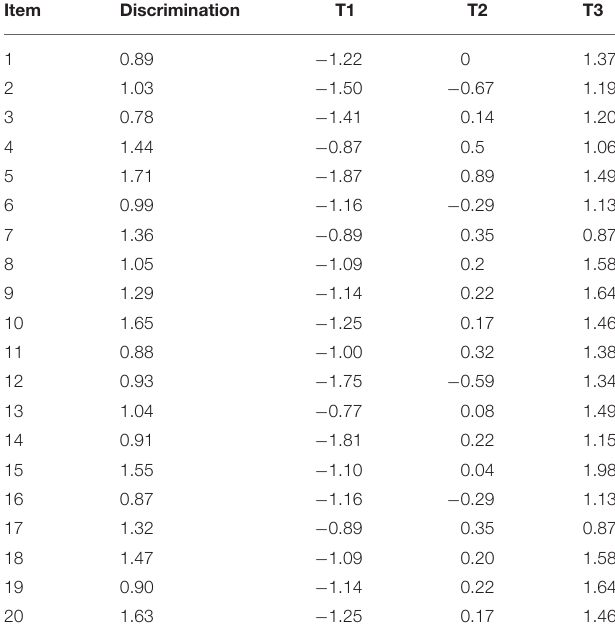
TABLE 1 | Data generating parameters for the graded response